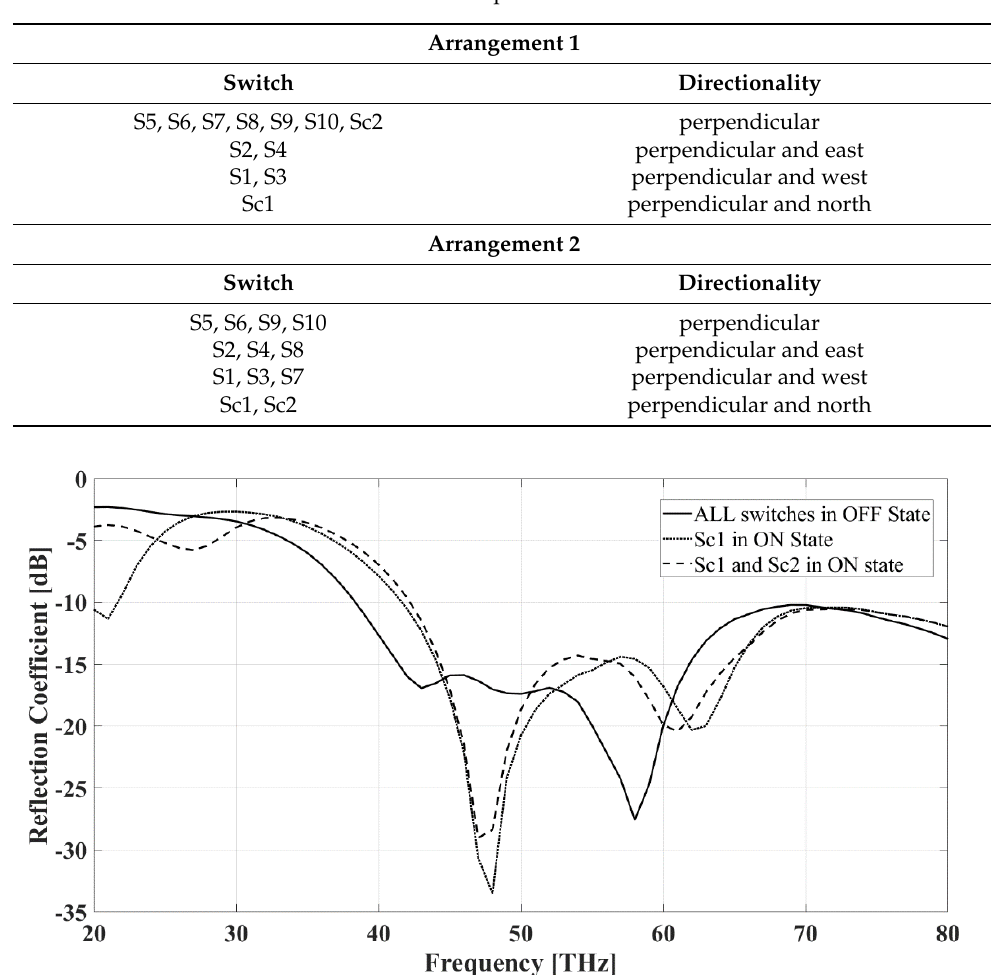
Figure 7. Reflection coefficient versus frequency when all of the switches are OFF, Sc1= ON, and Sc1 = Sc2 = ON. The simulations were done with the Sonnet Professional software.